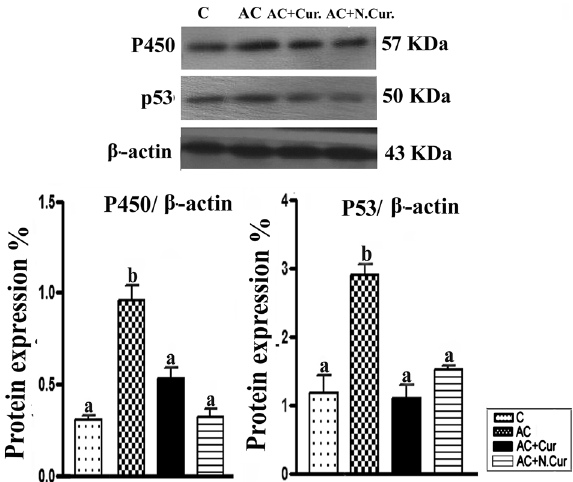
Figure 5. Western blot detection showing changes in protein levels of cytochrome P450 (CYP2E1) and P53. Results expressed as mean ± SEM. Values in the same column with unlike superscript letters are significantly different at p <